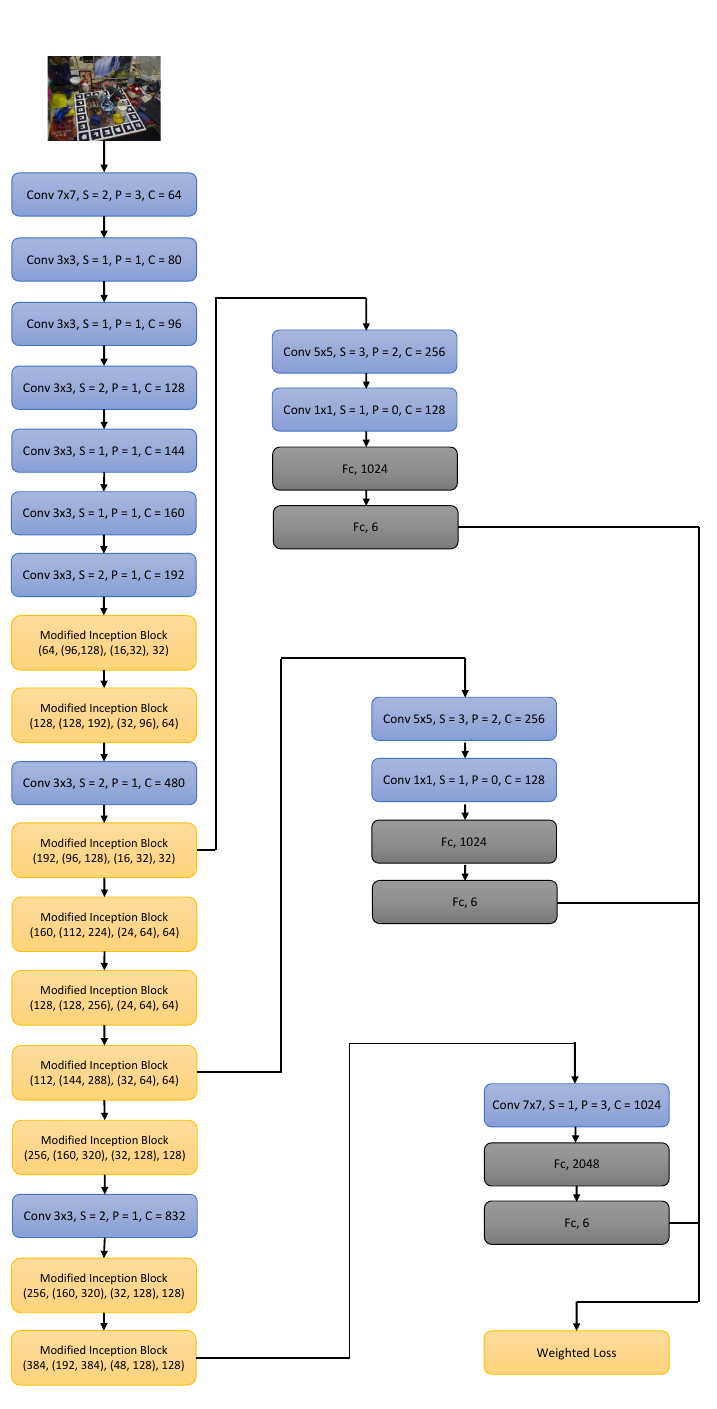
Figure 3. The proposed SynPo-Net architecture. Each convolutional layer is followed by batch normalization and a ReLU activation layer. The 6 (or 7) pose values regressed by the Convolu- tional Neural Network (CNN) represent the 3D translation and 3D rotation vector of lie algebra (or quaternion). The architecture variant with quaternions is only used for the ablation